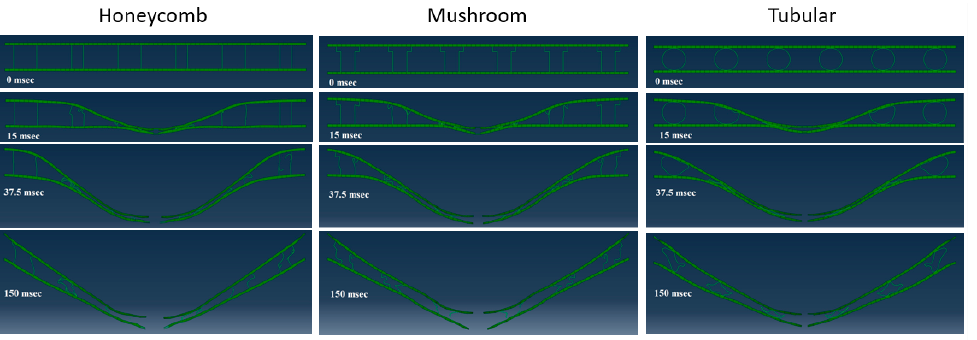
Figure 15. Damage development for different core shapes: honeycomb, mushroom, and tubular core with a façade plate thickness of 5 mm and core–core spacing of 112.5 mm.